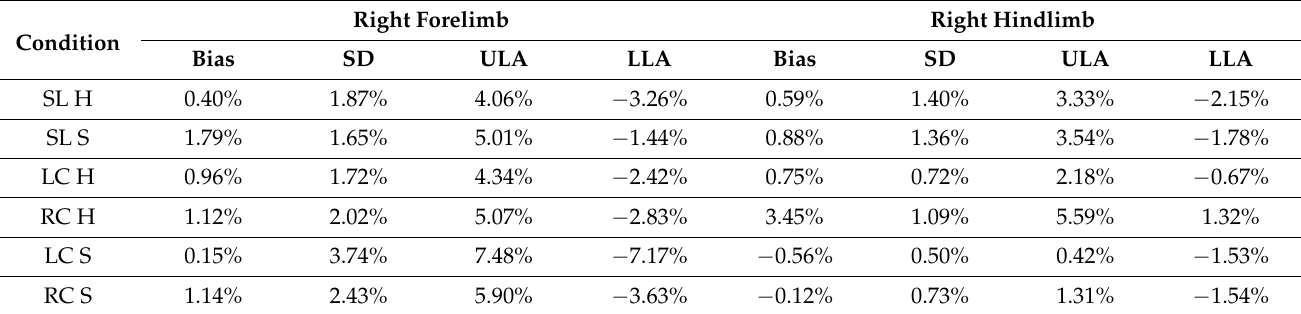
Table 2. Bland–Altman comparison (in percentage of stride duration%) of the reference foot-on event and the foot-on event detected with the developed method from the cannon bone data. Accuracy (bias), precision (SD), and upper/lower limits of agreement (ULA and LLA) were indicated for each condition: straight line (SL), left circle (LC), and right circle (RC), for both ground conditions—hard (H) and soft (S)—and for the right forelimb and right hindlimb. For the left-circle condition, the equipped limb was the one outside the circle. For the right-circle condition, the equipped limb was the one inside the circle. Results are in percentage of stride duration.